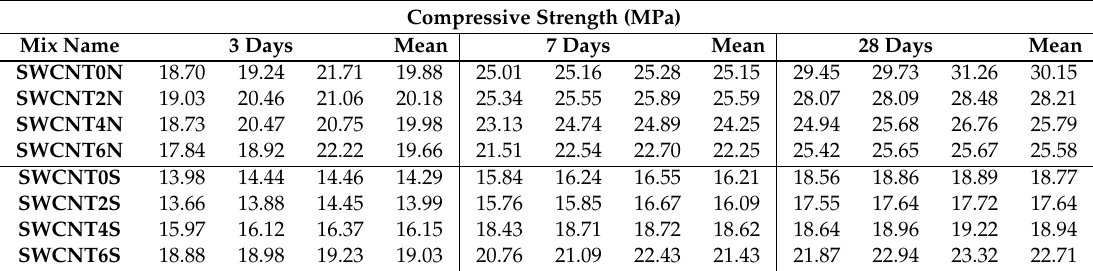
Table 11. Compressive strength test results of SWCNT-added specimens.